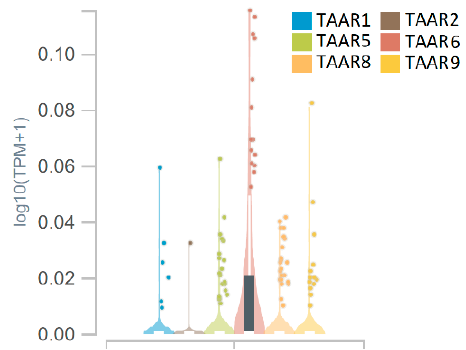
Figure 6. TAAR1, TAAR2, TAAR5, TAAR6, TAAR8 and TAAR9 expression in the human brain structures in male and female in the GTEx Analysis V8 (dbGaP Accession phs000424.v8.p2) dataset. Picture was generated by the GTEx Portal interactive interface.